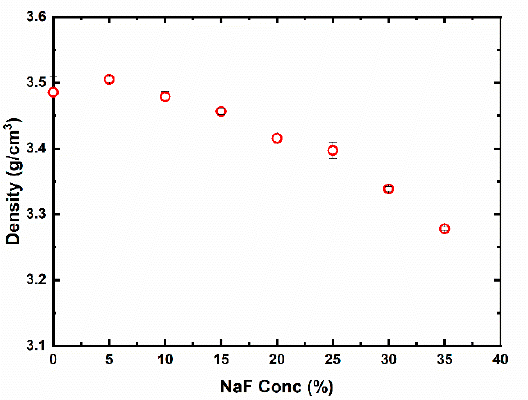
Figure 2. Variation of room temperature density measurements as a function of NaF concentra- tion.